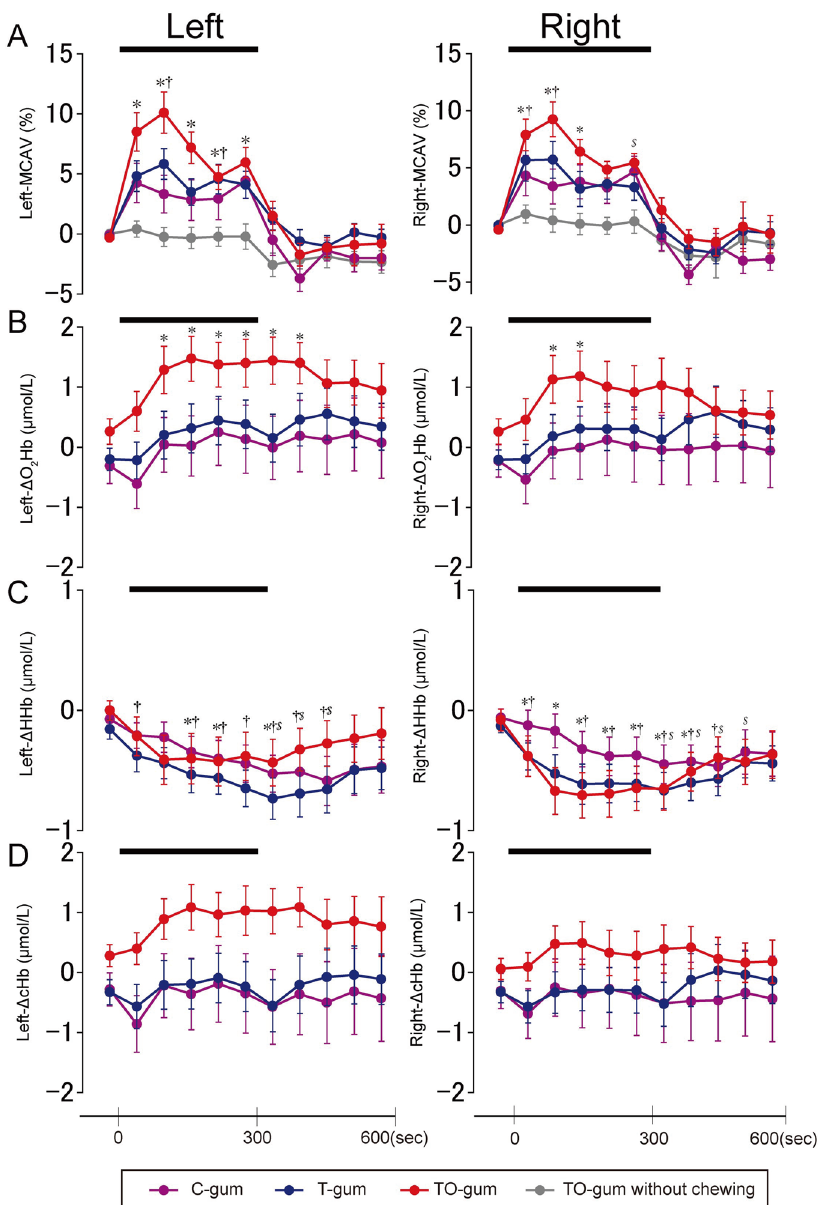
Figure 3. Temporal profiles of averaged (N=25) hemodynamic changes in the left and right hemispheres measured by TCD (A) and NIRS (B–D) during chewing of three different gums. In (A), the data obtained during putting the TO-gum on the tongue are also superimposed as gray lines. In the NIRS signals (B–D), D O 2 Hb is shown in (B), D HHb in (C), and D cHb in (D). Data are represented as mean 6 SEM every 1 min. A bold bar in each panel indicates the duration of the gum-chewing test. Statistical comparisons were performed between the control value (i.e., before chewing) and the value measured at each time point. Significant differences are represented by individual symbols: *, control vs. TO-gum; { , control vs. T-gum; $ , control vs. C-gum. Statistically significant levels were set at P=0.005 (=0.05/10) by one-way ANOVA and Bonferroni’s correction for multiple comparisons.